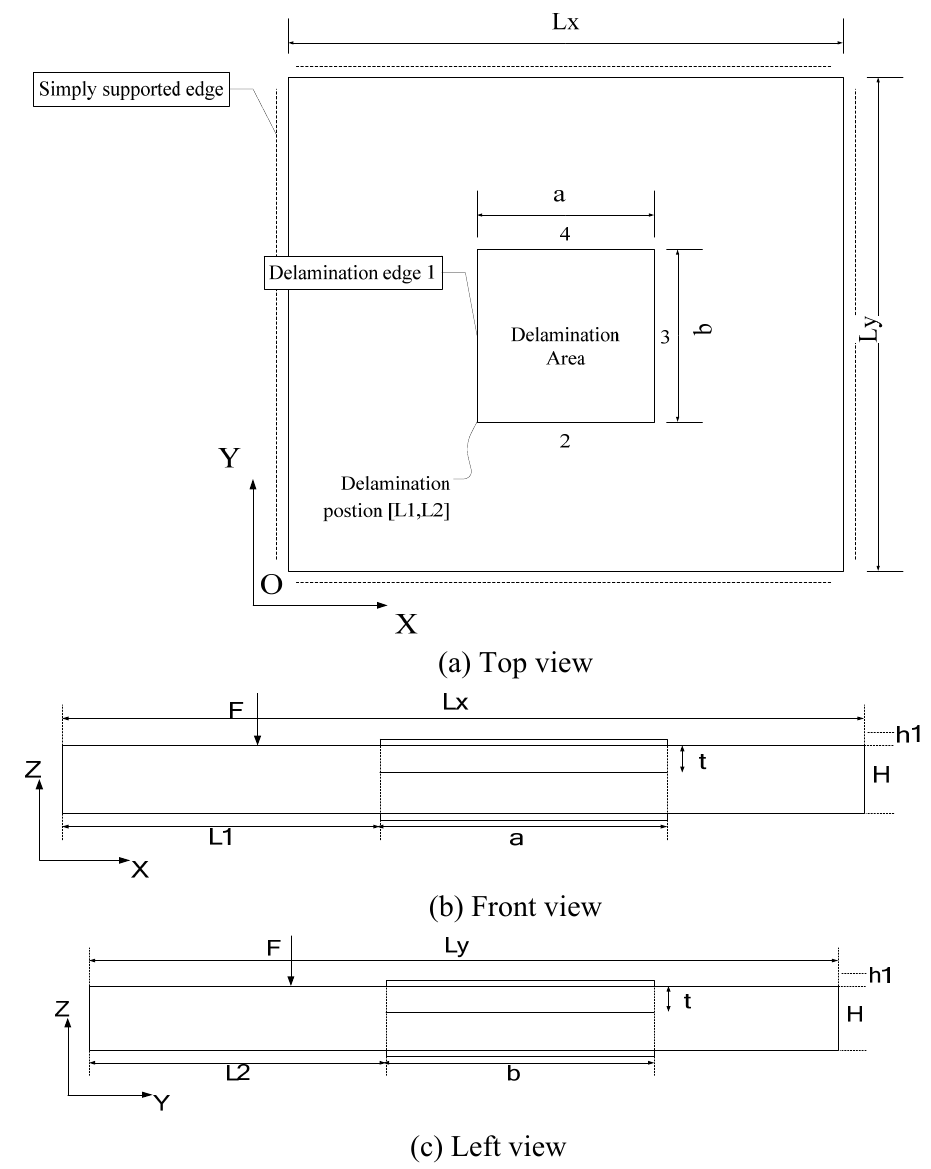
Figure 14. A delaminated plate structure (adopted from Figure 1 in [58]).